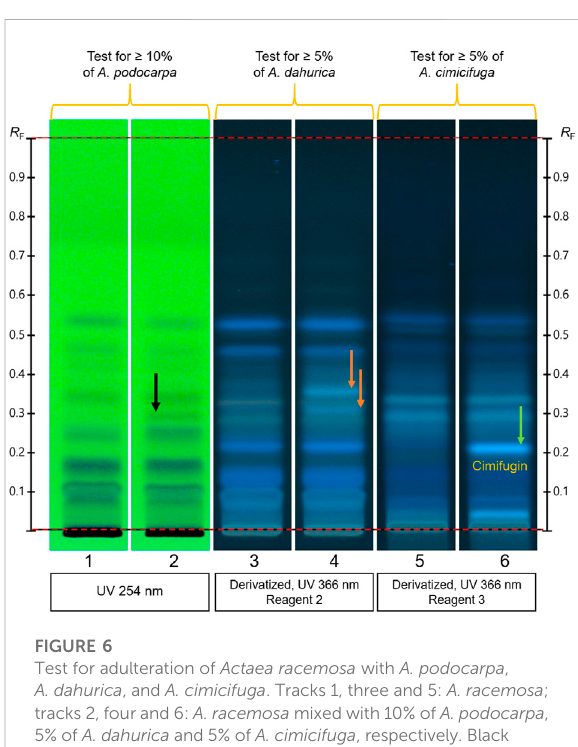
FIGURE 6 Test for adulteration of Actaea racemosa with A. podocarpa , A. dahurica , and A. cimicifuga . Tracks 1, three and 5: A. racemosa ; tracks 2, four and 6: A. racemosa mixed with 10% of A. podocarpa , 5% of A. dahurica and 5% of A. cimicifuga , respectively. Black arrow: zones characteristic of A. podocarpa root; orange arrows: zones characteristic of A. dahurica root; green arrow: zone due to cimifugin, characteristic of A. cimicifuga